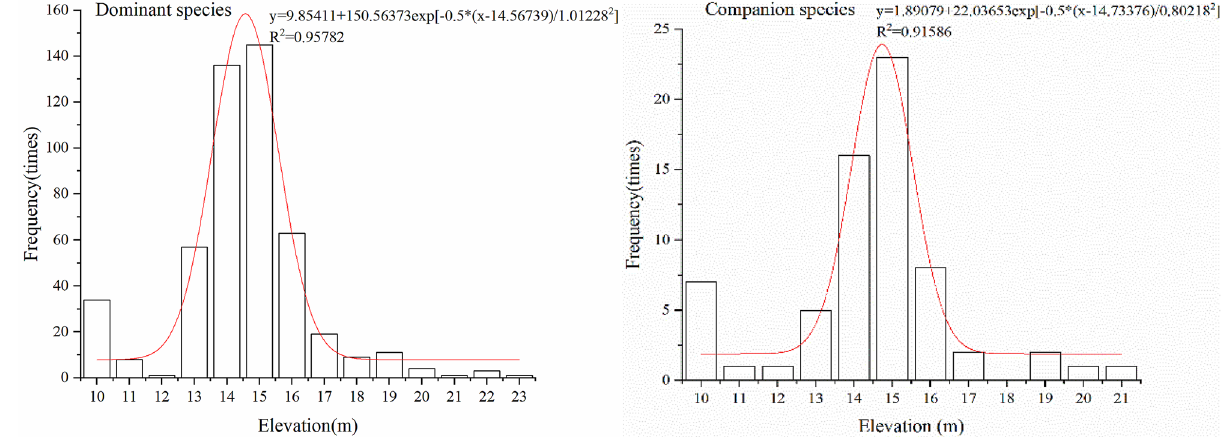
Figure 8. Gaussian population distribution characteristics of C. cinerascens at different